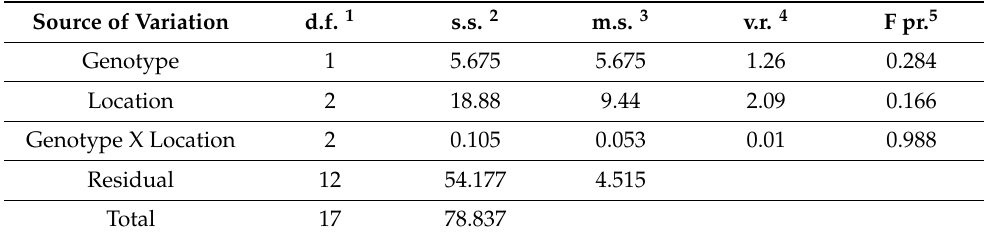
Table 2. ANOVA for marketable tuber yield per plant for the test genotypes across the three locations. Source of